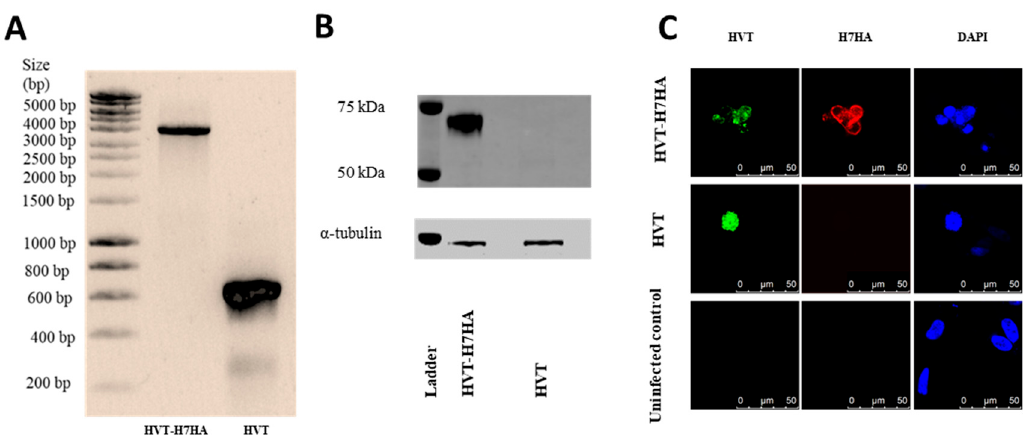
Figure 4. Characterization of HVT–H7HA. ( A ) PCR products of H7HA antigen cassette inserted between UL45 and UL46; ( B ) Western blot detection of H7HA protein from HVT–H7HA-infected CEF cells. Comparable protein loading in each lane was demonstrated by α -Tubulin detection. ( C ) Analysis of HA expression by indirect immunofluorescence assay. The H7HA was detected by staining with H7HA-specific mouse monoclonal antibody, followed by Alexa Fluor 568-labeled anti-mouse secondary antibody (red fluorescence). The HVT was detected by staining with HVT chicken antiserum, followed by Alexa Fluor 488-labeled anti-chicken secondary antibody (green fluorescence). The nuclei were stained with DAPI (blue fluorescence).